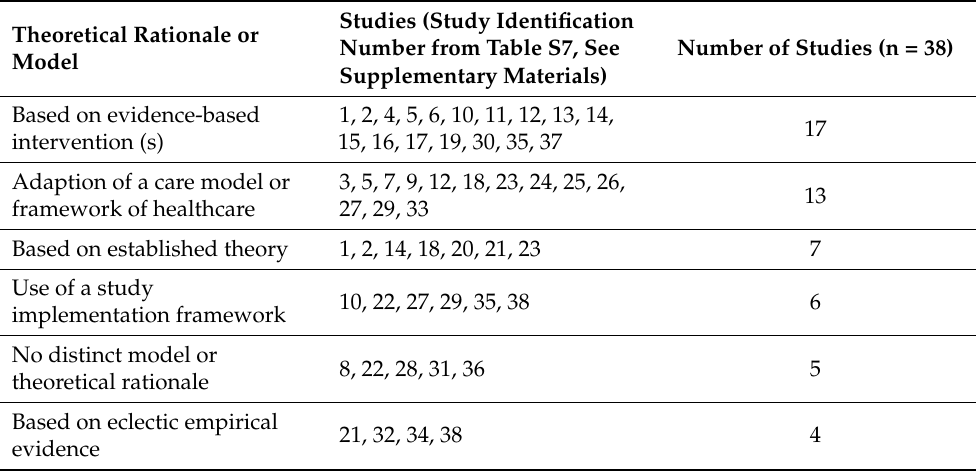
Table 4. Theoretical rationale or model of interventions to promote the utilization of physical health care for people with a